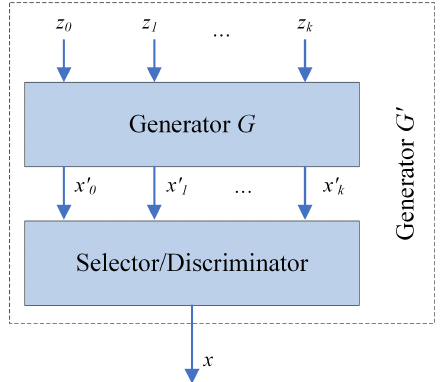
Figure 6. Metropolis-Hastings GAN (MH-GAN)